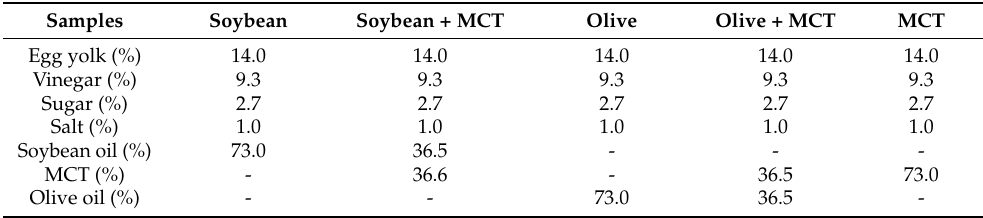
Table 1. Mayonnaise